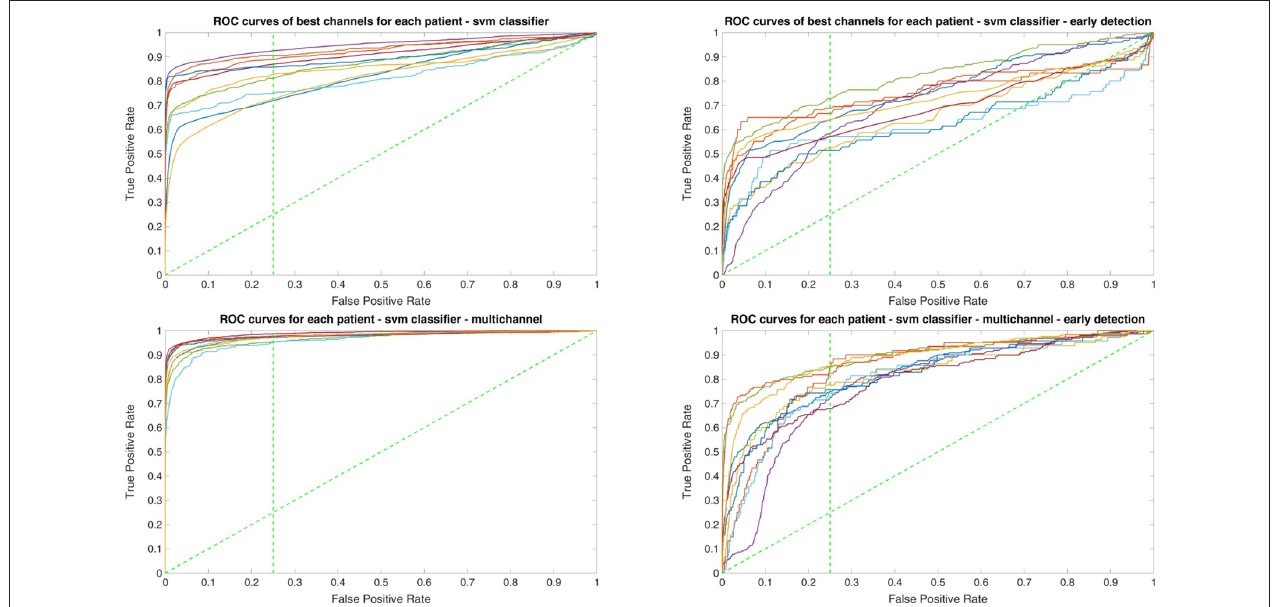
FIGURE 6 | ROC curves of all patients in single and multichannel mode for the support vector machine (SVM) classifier. The dashed line separates the early retrieval area.